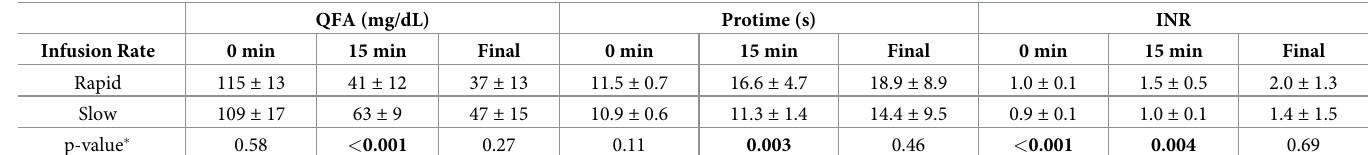
Table 4. Coagulation testing